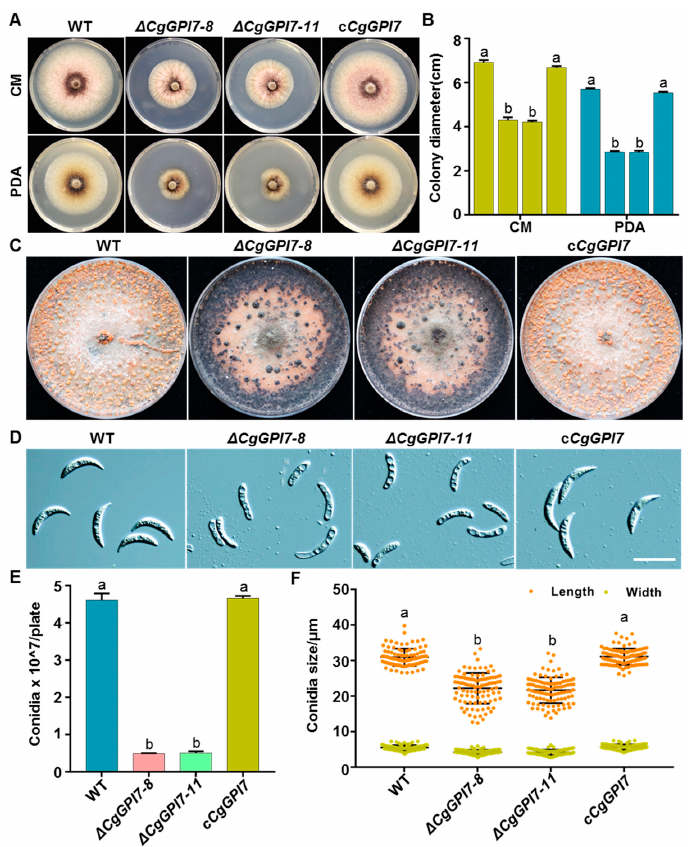
Figure 2. Biological phenotypic analysis of CgGPI7 knockout mutants. ( A ) Colony morphology of wild type, Δ CgGPI7-8 , Δ CgGPI7-11, and c CgGPI7 grown on CM and PDA medium. ( B ) Statistical analysis of the colony diameters. Bar indicates the standard deviation of three replicates and the small letters indicate a significant difference ( p < 0.01). ( C ) Sporulation of indicated strains on OA medium. ( D ) Conidia morphology of indicated strains. Scale bars = 25 μ m. ( E ) Statistical analysis of the sporulation of indicated strains. Bar indicates the standard deviation of three replicates and the small letters indicate a significant difference ( p < 0.01). ( F ) Statistical analysis of the conidia length and width of indicated strains. Bar indicates the standard deviation of 100 replicates and the small letters indicate a significant difference ( p < 0.01).